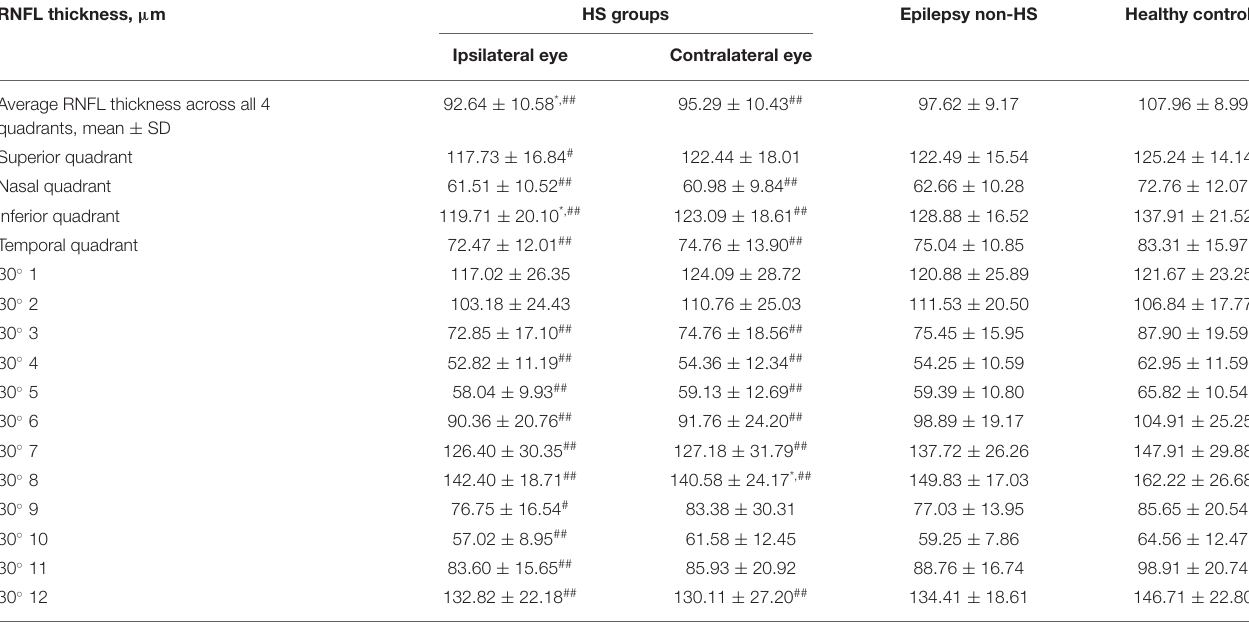
TABLE 2 | The RNFL thickness comparison in people with HS, epilepsy non-HS and healthy